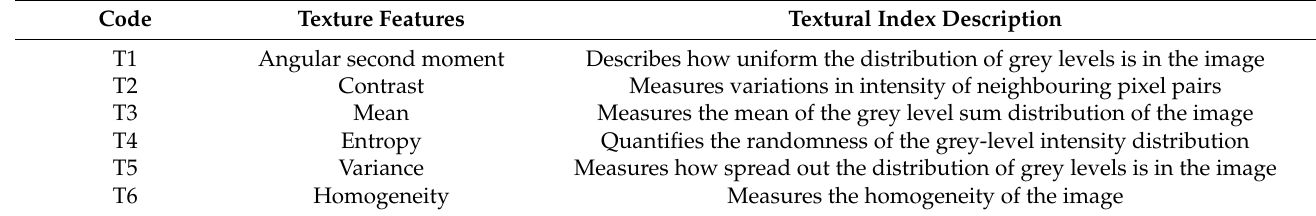
Table 1. Texture metrics computed using